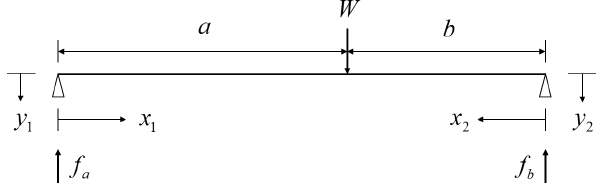
Figure 2. Equivalent balance shaft model with bearing reaction in inline 4-cylinder